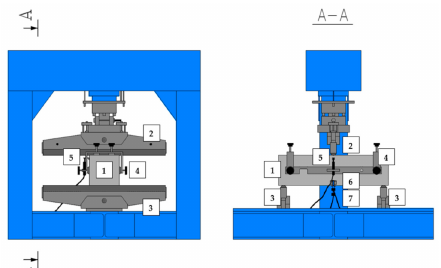
Figure 4. Set-up for three-point bending test: 1—sample; 2—loading roller; 3—supporting roller; 4—rigid frame to install LVDT; 5—LVDT to measure δ ; 6—clip gauge to measure CTOD; 7—clip gauge to measure CMOD.